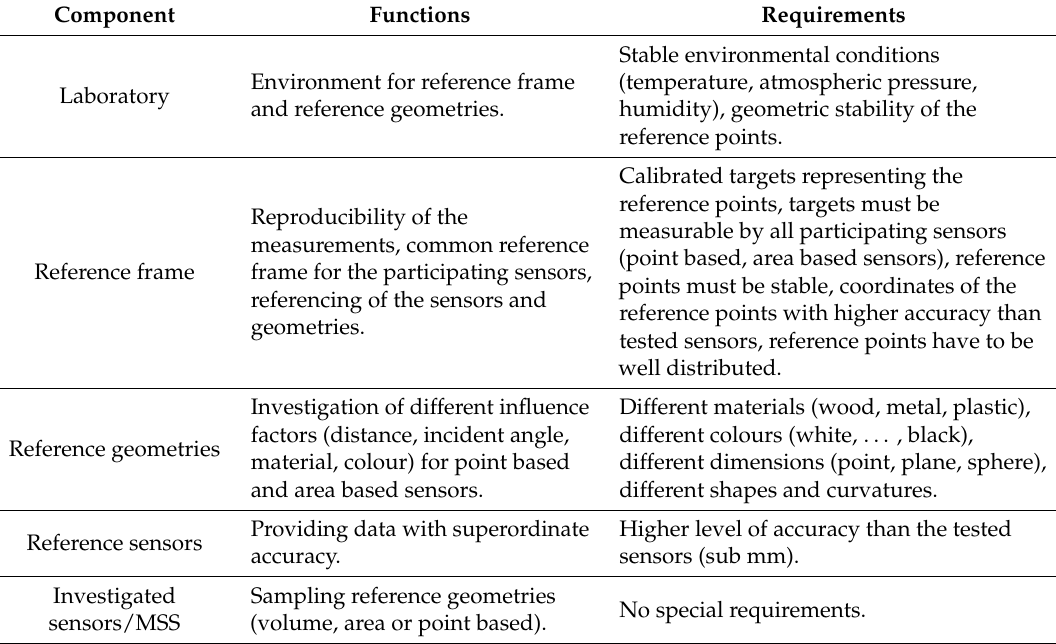
Table 1. Environment for the calibration of geodetic sensors and